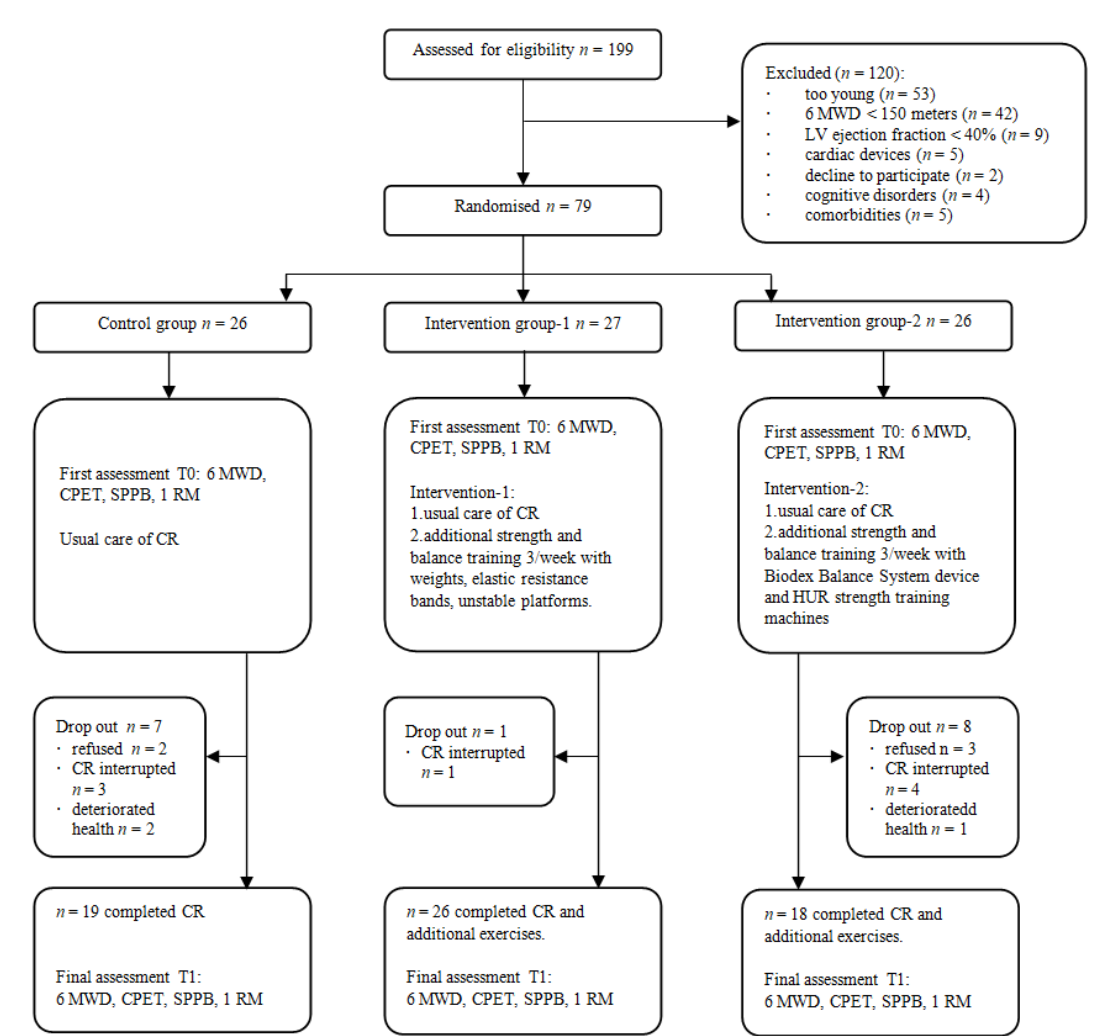
Figure 1. Study flow